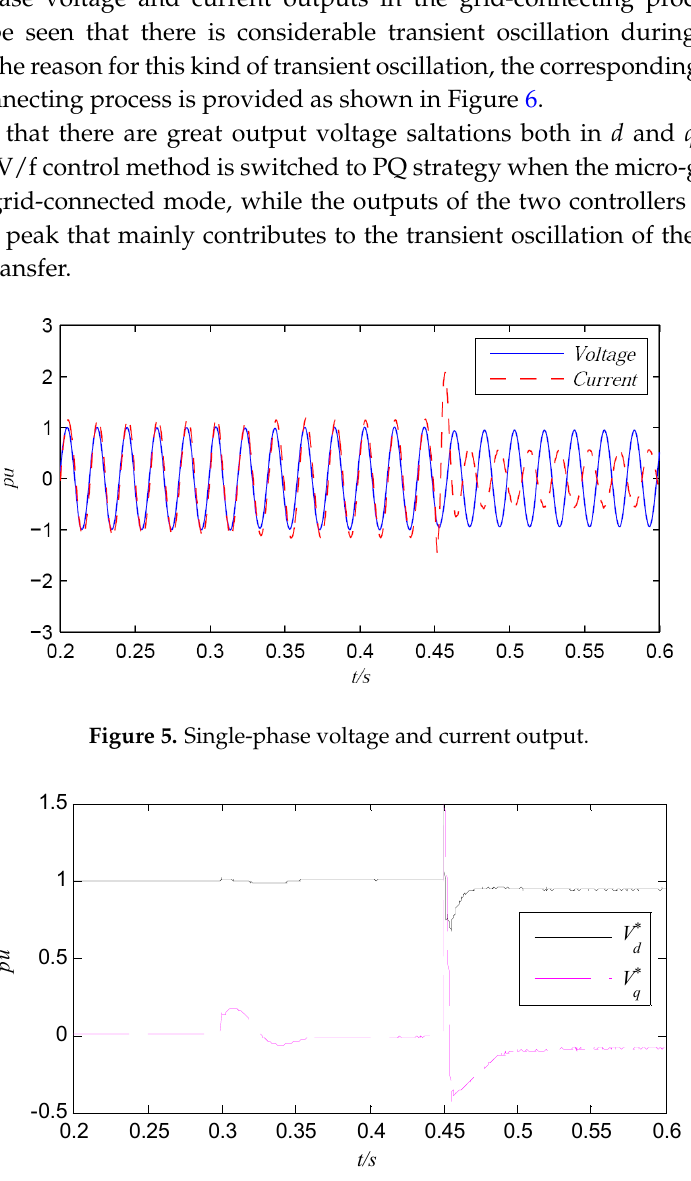
Figure 7. Single ‐ phase voltage and current output. It can be seen that the occurrence of transient oscillation is more acute when the micro ‐ grid switches from grid ‐ connected mode to islanding mode. To further analyze the reason for this kind of transient oscillation, in a similar manner, the corresponding controller output during the islanding process is considered as shown in Figure 8. It can be seen that there are also great output voltage saltations both in d and q axis coordinates, which lead directly to the transient oscillation of the islanding process. This is due to the fact that the d axis component of the offline operating V/f controller is based on the voltage vector of the main grid when grid ‐ connecting, while the d axis component of the online operating V/f controller is based on the voltage vector of the micro ‐ grid when grid ‐ islanding. As a consequence, when the micro ‐ grid is separated from the main grid and the controller is switched from PQ to V/f strategy, it is the